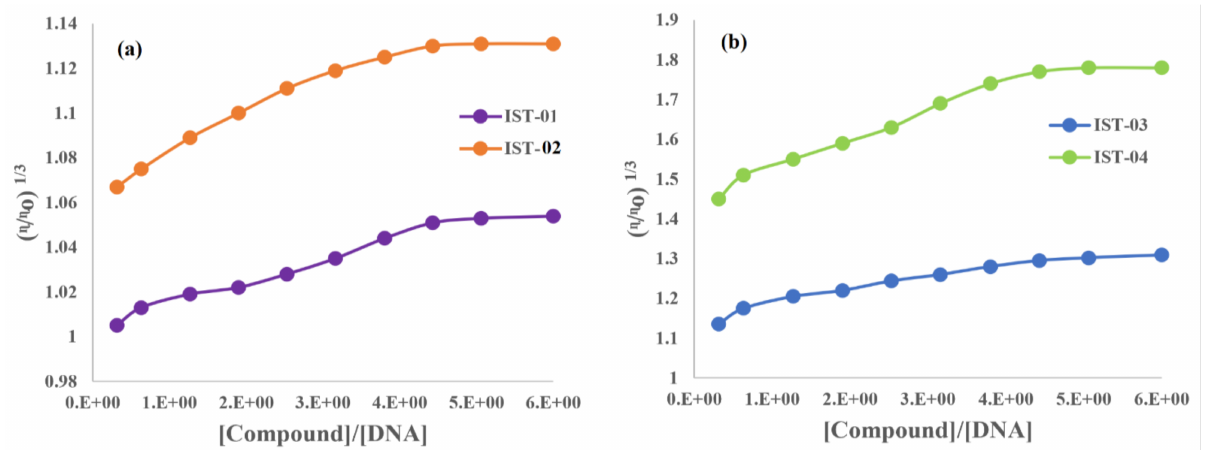
Figure 13. Plot of relative specific viscosity vs. [Compound]/[DNA] for: ( a ) IST-01 and IST-02, ( b ) IST-03 and